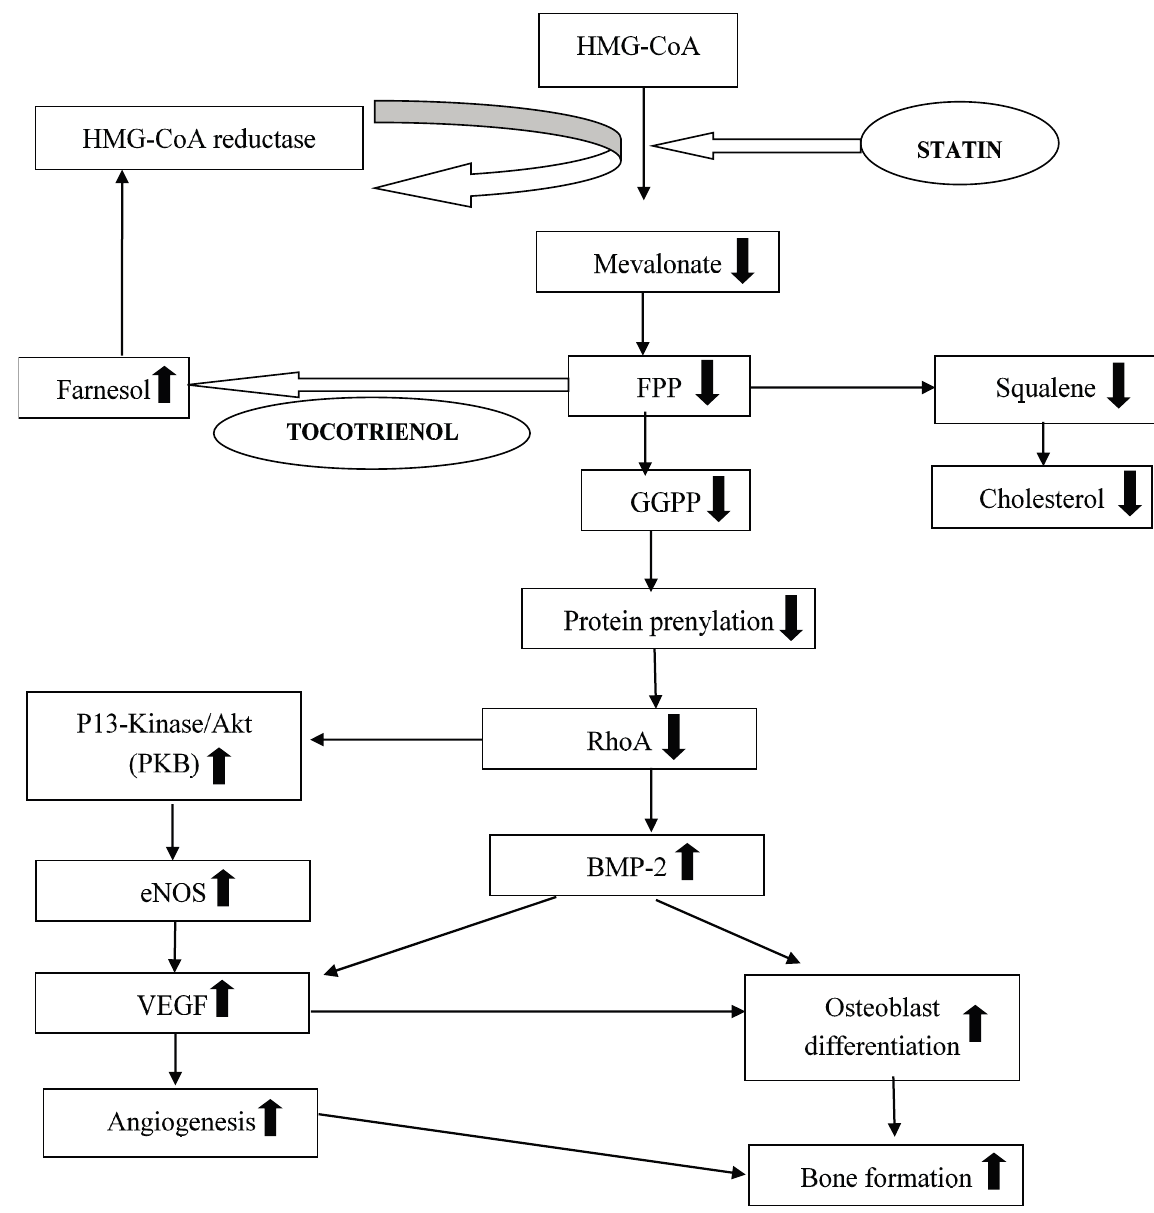
Figure 10. The different mechanisms of tocotrienol and statin to suppress the activity of HMG-CoA reductase. The figure was modified from Ibrahim et al. 2013